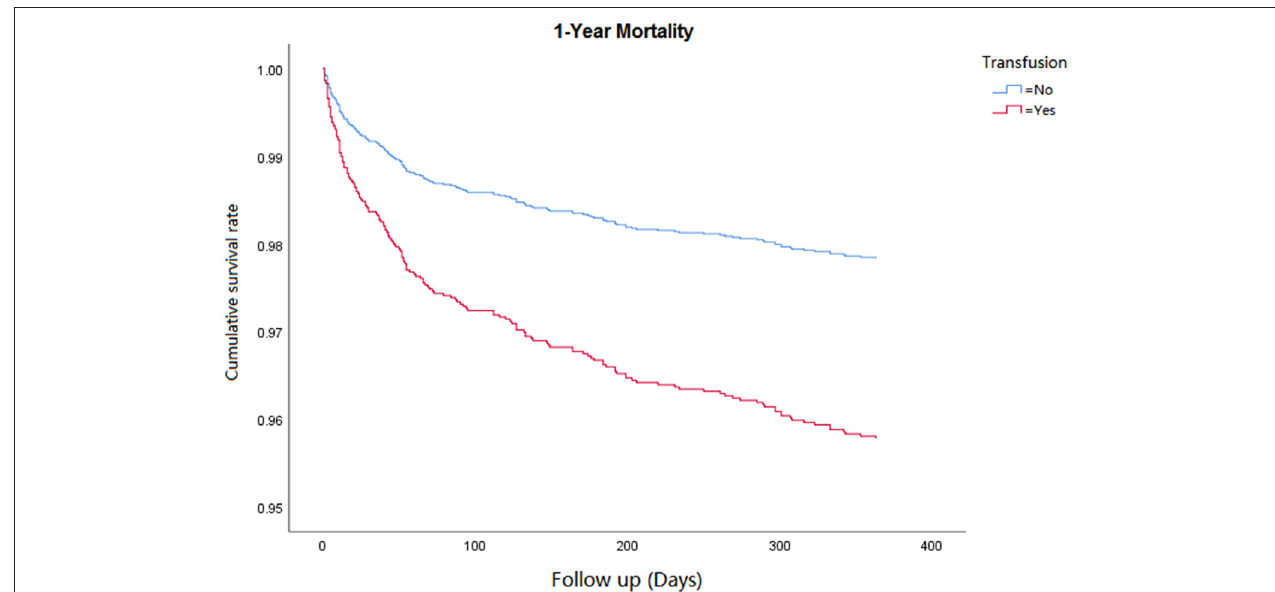
FIGURE 1 | Correlation between perioperative red blood cell transfusion and 1-year mortality.